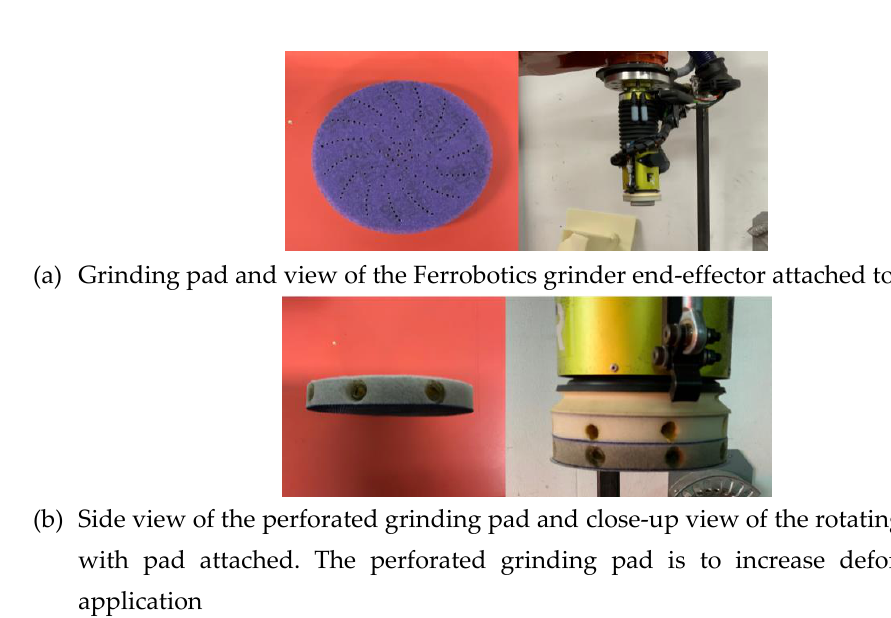
Figure 10. Robotic arm grinding head end-effector.